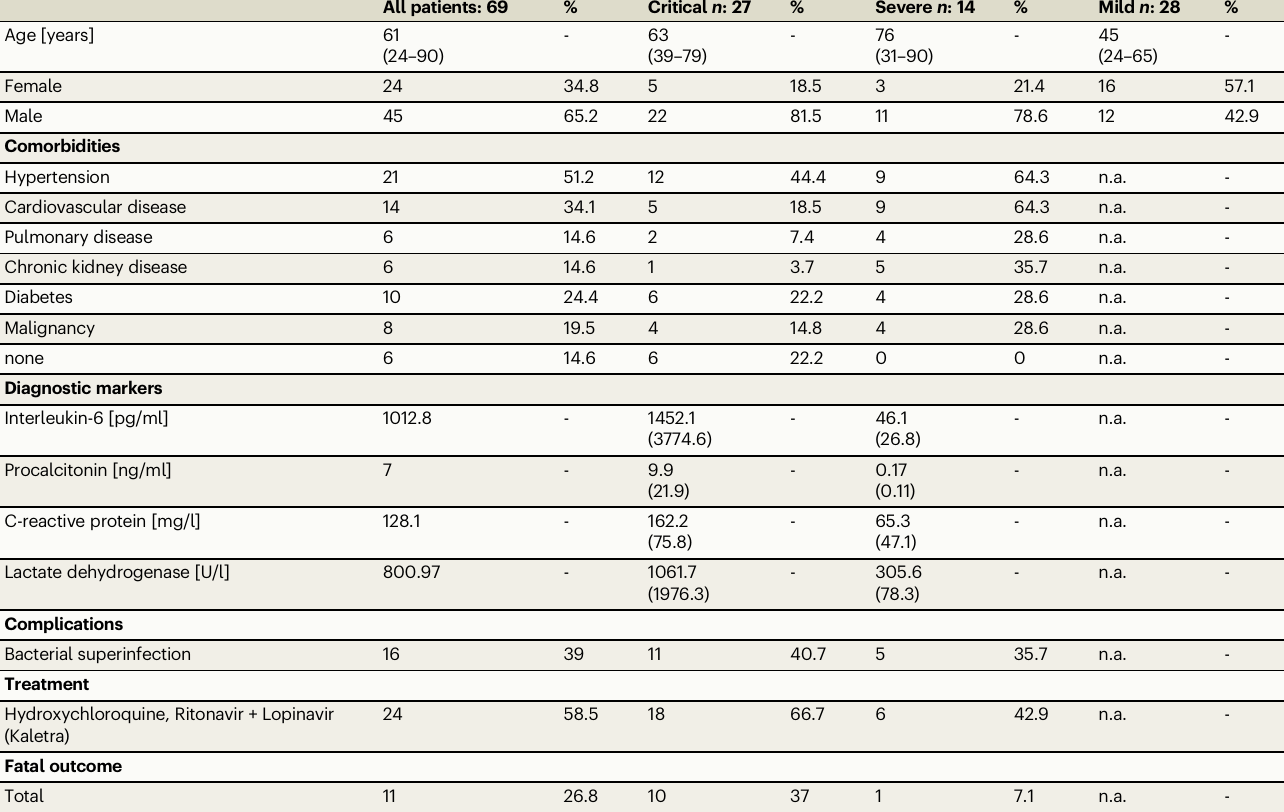
Table 1 | Clinical characteristics of SARS-CoV-2-infected patients All patients: